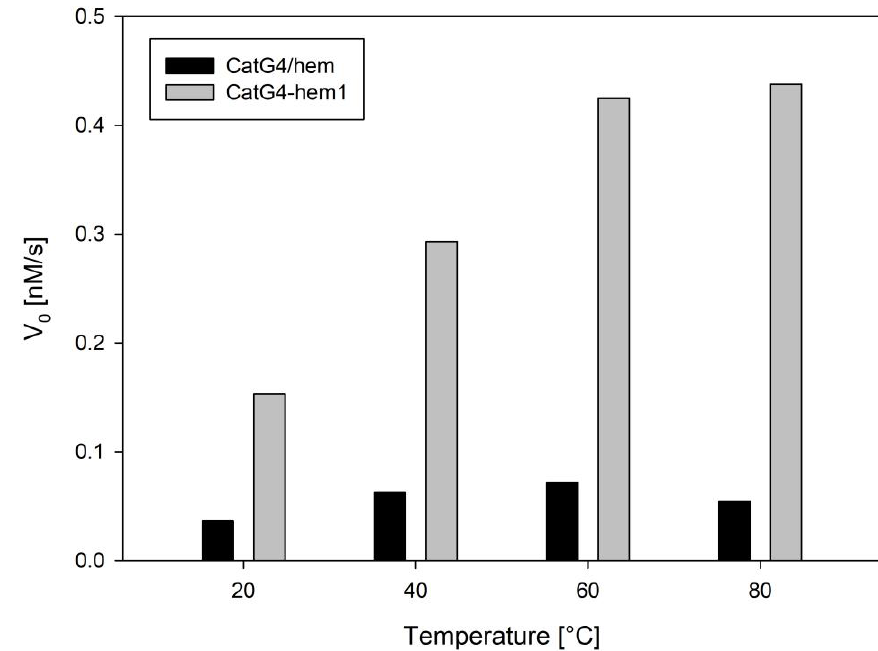
Figure 5. Peroxidase activity of the CatG4/hemin complex (black) and the CatG4–hem1 conjugate (gray) at various temperatures. Conditions: 0.05 µM DNA, 0.05 µM hemin (if present), 100 mM KCl, 10 mM Tris-HCl (pH 8.0), 1 µM Amplex Red, and 10 µM H 2 O 2 .